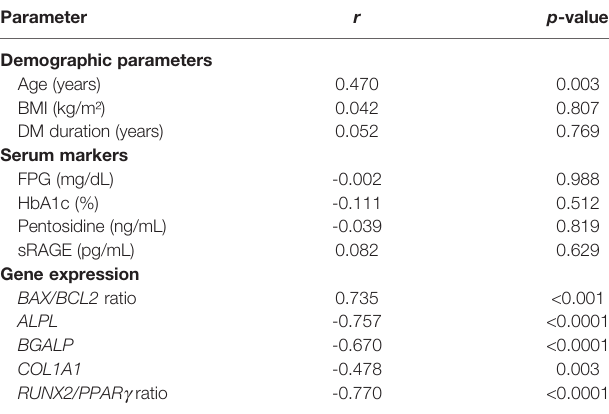
TABLE 4 | Factors associated with AGER